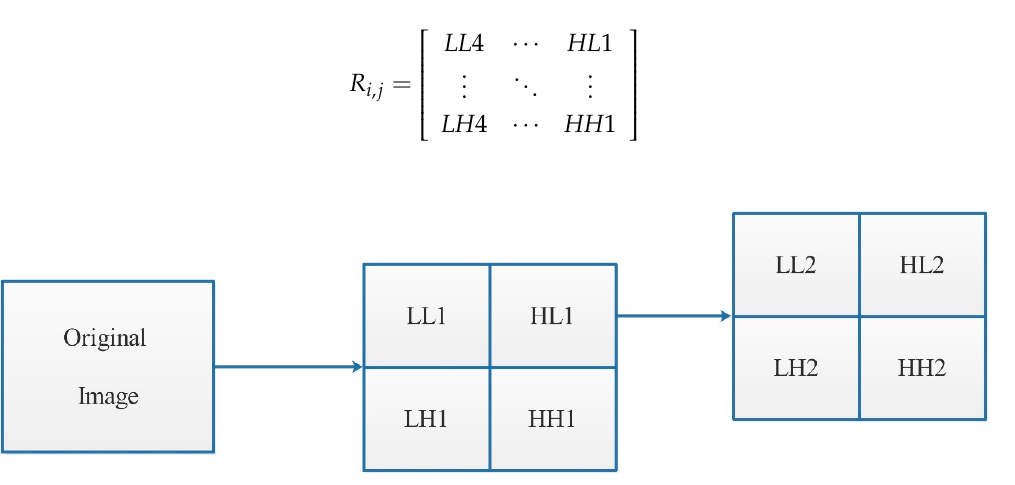
Figure 2. The image segmentation proposed method.